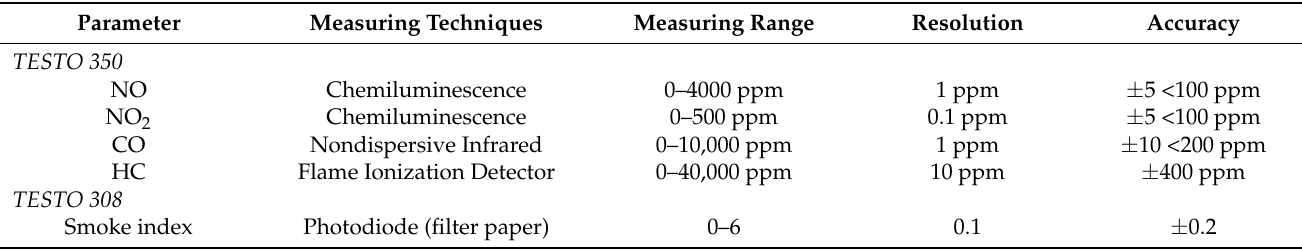
Table 2. Specifications of the engine exhaust gas analyzer.